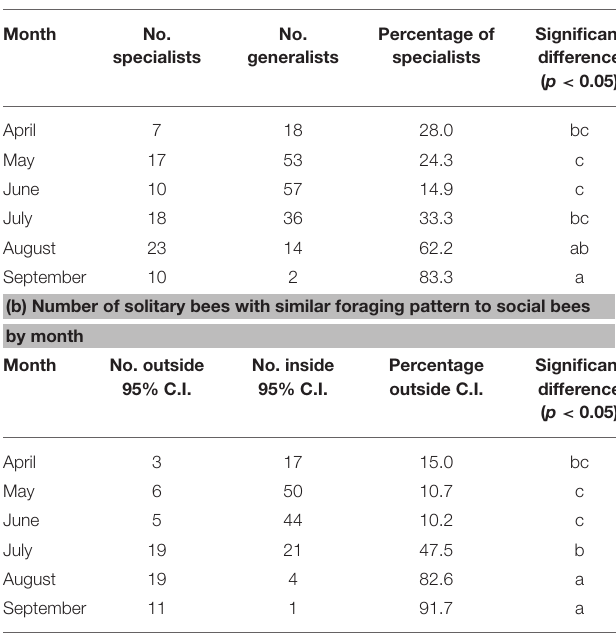
Different letters within the right hand column indicate differences in the proportion of specialized bee species across time (pairwise comparison of